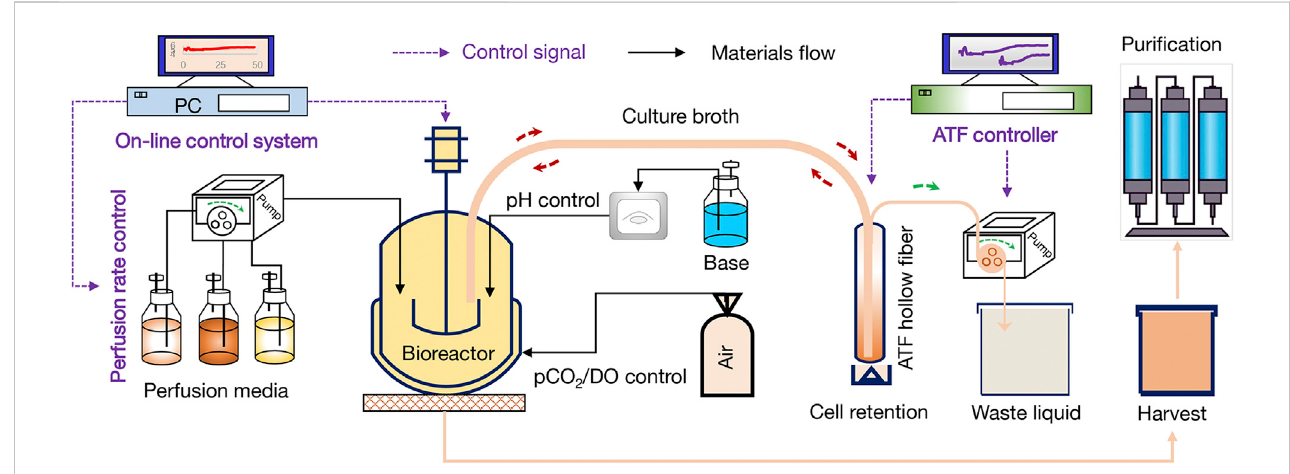
FIGURE 1 Schematic diagram of the CHO perfusion culture for the production of anti-PD-1 monoclonal antibody (mAb).